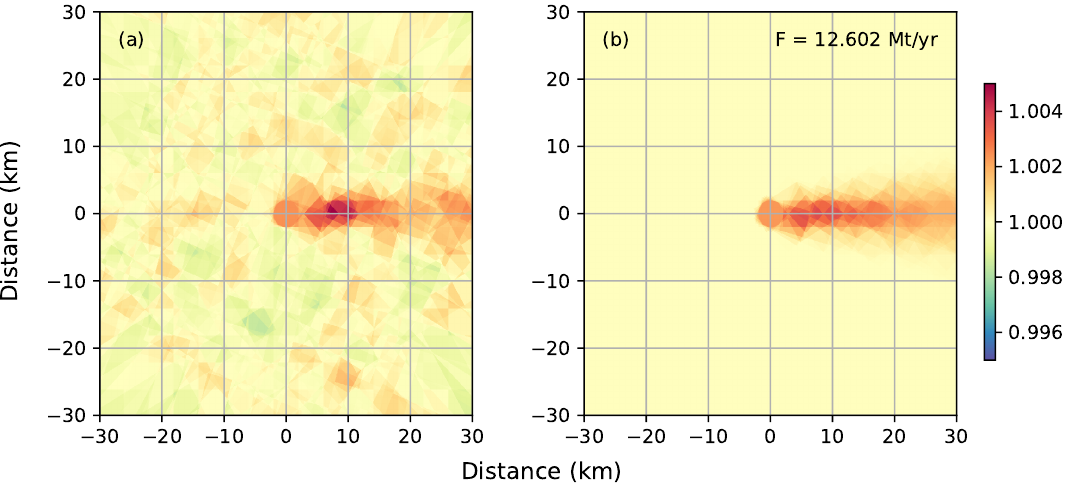
Figure 10. XCO 2 observations relative to a 400 ppm background for one instance of the 30 member ensemble. ( a ) Average observations from 6 simulated images at varying wind directions for a 13 Mt yr − 1 source. ( b ) Fitted relative XCO 2 enhancements from the least squares fit. The label identifies that the estimated emission rate was 12.602 Mt CO 2 yr − 1 for this individual ensemble